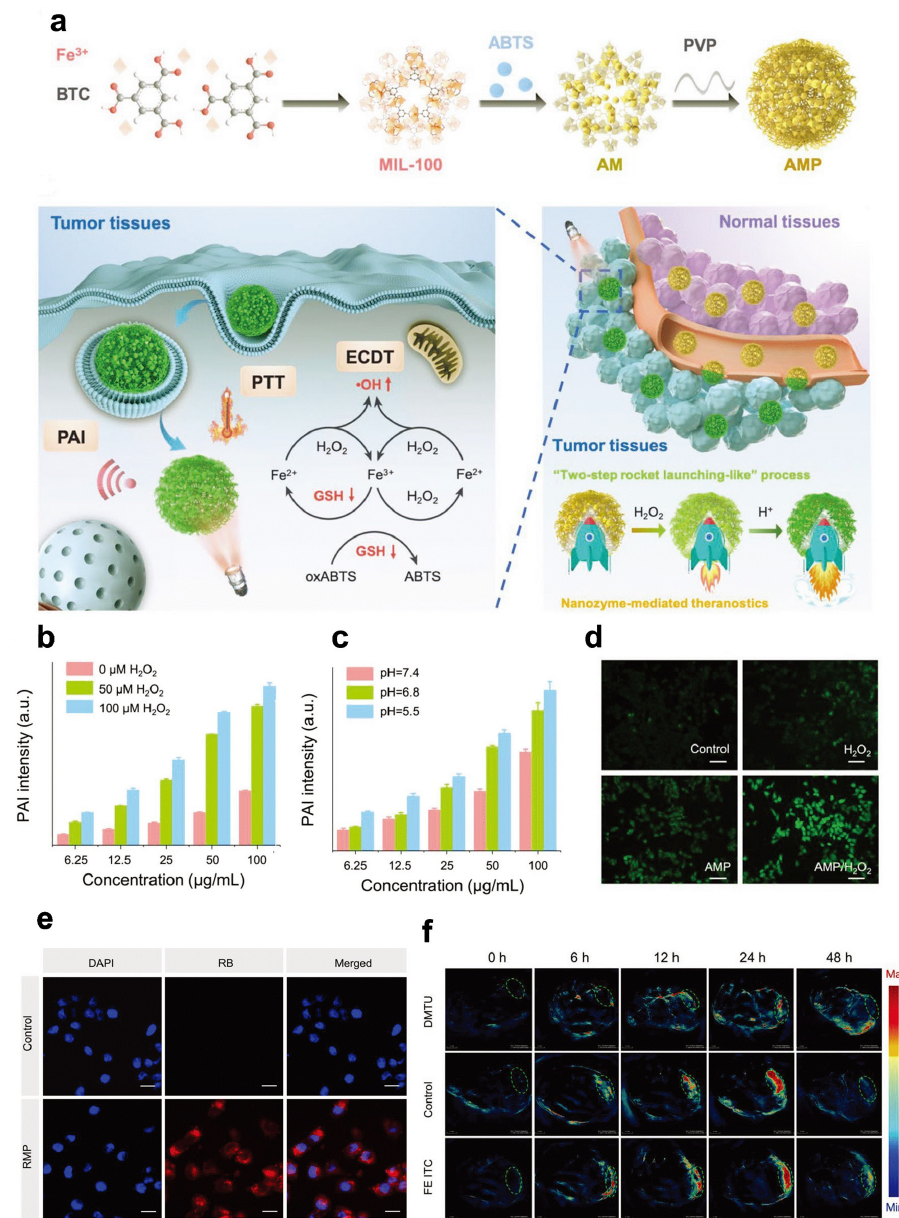
Figure 4. AMP NRs for PAI. ( a ) Preparation procedure and schematic illustration of AMP NRs for tumor-microenvironment-activated nanozyme-mediated theranostics. ( b ) PAI signal intensity of AMP NRs with different concentrations of H 2 O 2 . ( c ) PAI signal intensity of AMP NRs at different pH values in the presence of 100 × 10 − 6 M H 2 O 2 . ( d ) Detection of ROS levels in 4T1 cells treated with different formulations. ( e ) CLSM images of 4T1 cells treated with AMP NPs (B@MIL-100/PVP). ( f ) Representative PAI images of tumors after different treatments. Reproduced with permission from Ref. [106]. Copyright © 2019 WILEY-VCH Verlag GmbH & Co. KGaA, Weinheim.